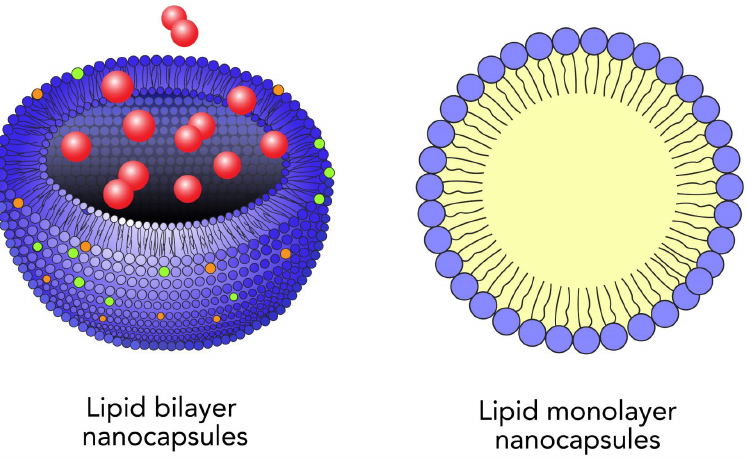
Figure 1. Example of mono and bilayer